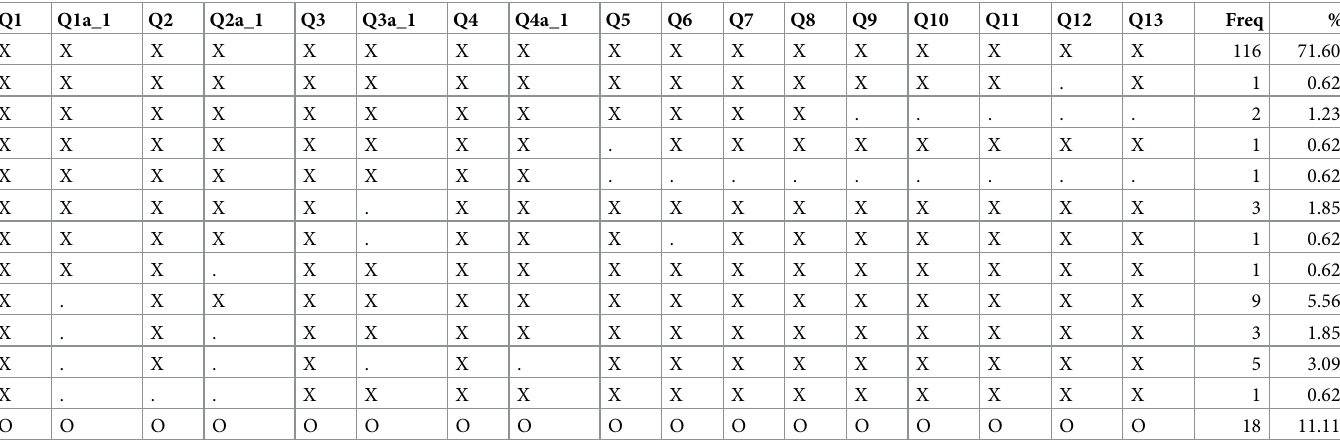
Table 2. Missing data by survey question. ‘X’ indicates non-missing. ‘O’ or ‘.’ are